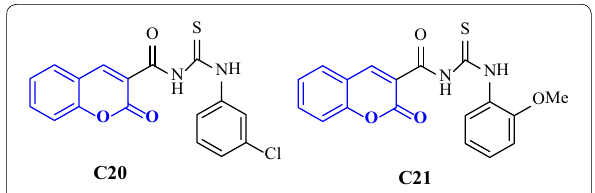
Fig. 28 Chemical structure for thiourea coumarin derivatives C20 and C21